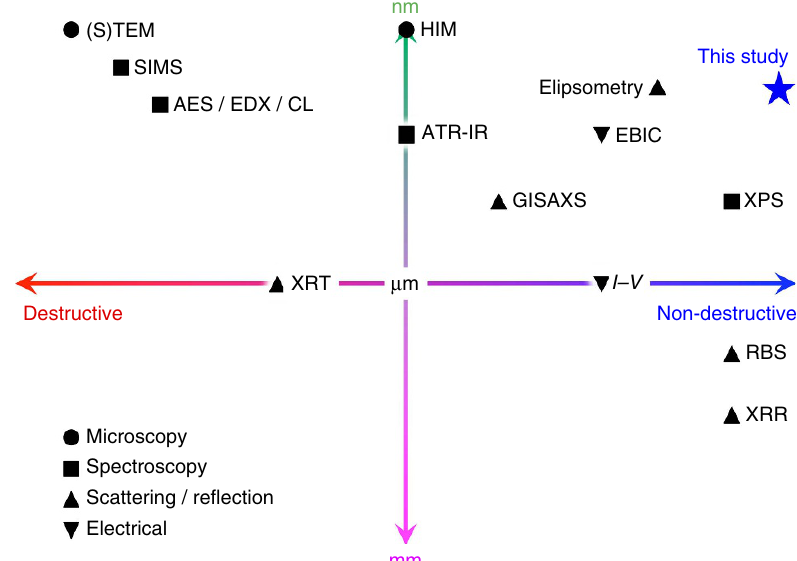
Figure 1 | Evaluation techniques for embedded junctions. Major techniques for the evaluation of buried junctions against destructiveness and resolution, including those based on microscopy (closed circles), spectroscopy (closed squares), scattering and reflection (closed triangles), and electrical methods (closed inverse triangles). For the microscopic methods, (S)TEM and HIM denote (scanning) transmission electron microscopy and Helium ion microscopy. For the spectroscopic methods, SIMS, AES, EDX, CL, ATR-IR and XPS denote secondary ion mass spectroscopy, Auger electron spectroscopy, energy dispersive X-ray spectroscopy, cathode luminescence, attenuated total reflection-infrared spectroscopy and X-ray photoelectron spectroscopy, respectively. For the scattering and reflection methods, XRT, GISAXS, RBS and XRR represent X-ray topography, grazing-incident small-angle X-ray scattering, Rutherford backscattering and X-ray reflectivity, respectively. For the electrical methods, I–V indicates current–voltage